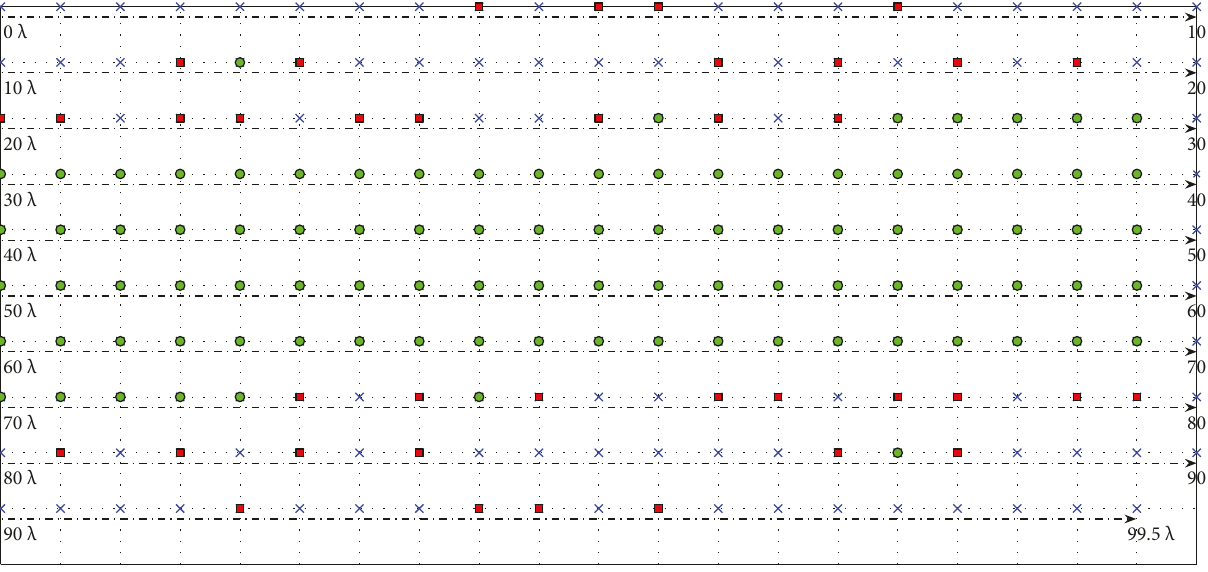
Figure 3: The element locations of the symmetrical TLA with a fi lling factor of 66% obtained by the IFT.